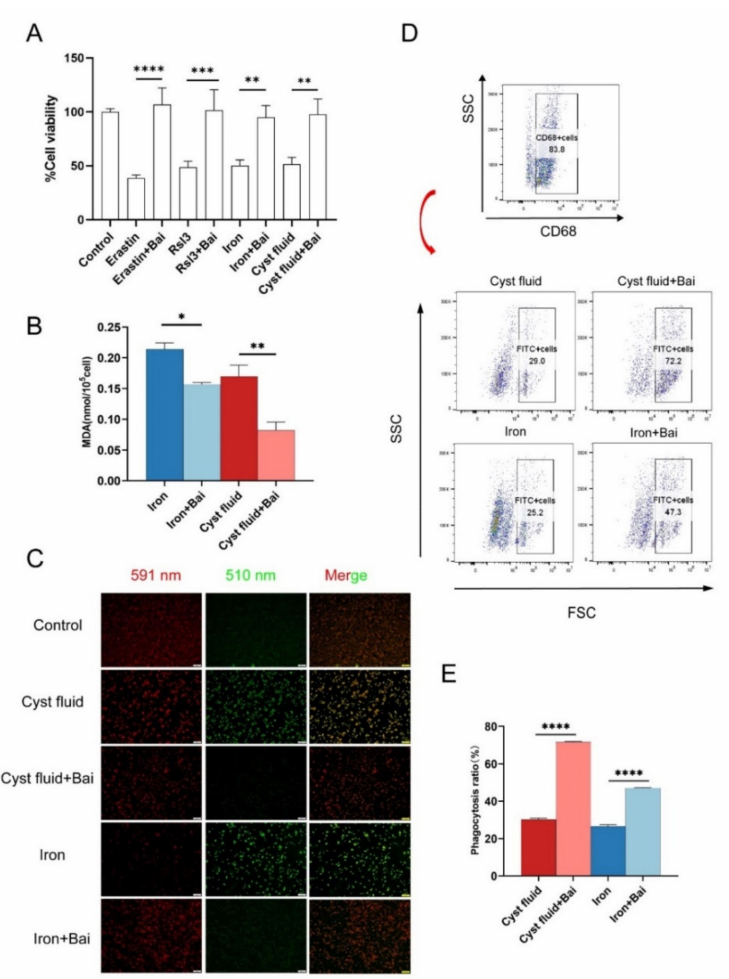
Figure 5. Baicalein inhibits macrophages’ ferroptosis and protects the phagocytic function. ( A ) PMA- stimulated THP-1 cells with different treatments as shown in the picture for 24 h (erastin, 10 µ M; RSL3, 5 µ M; cyst fluid, 2%; FeSO 4 solution, 200 µ g/mL; baicalein, 20 µ M) in 96-well plates for 24 h. Cell viability was measured with CCK-8. ( B ) Intracellular MDA levels in THP-1 cells after incubation with 2% cyst fluid and 200 µ g/mL FeSO 4 in the absence or presence of baicalein for 12 h. ( C ) Representative images of C11-BODIPY (581/591) staining in THP-1 cells with different treatments (cyst fluid, 2%; FeSO 4 solution, 200 µ g/mL; baicalein, 20 µ M). 591nm shows the reduction state, and 510nm shows the oxidation state. Scale bar = 100 µ m. ( D , E ) Representative image of phagocytosis ratio of macrophages treated with cyst fluid and iron in the absence or presence of baicalein verified by flow cytometric analysis. Phagocytosis ratio = FITC+CD68+cells/CD68+cells. Bai: baicalein. * p < 0.05, ** p < 0.01, *** p < 0.001, **** p <